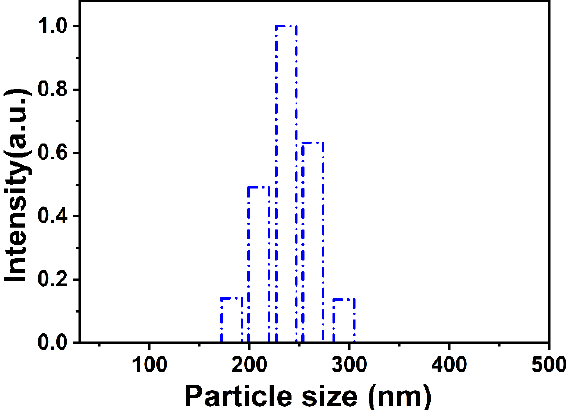
Figure 4. Size distributions (DLS) of SiO 2 -Def nanoparticles.